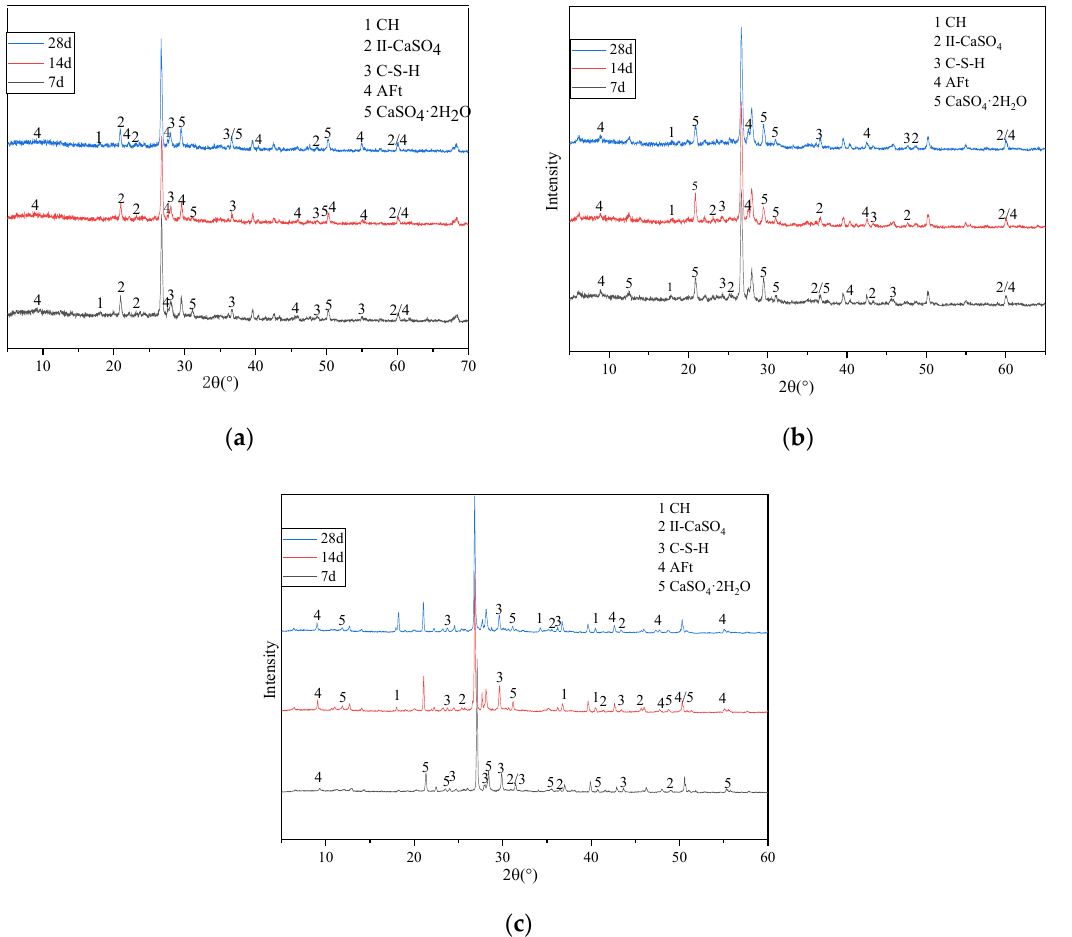
Figure 14. XRD patterns of samples with 30% cementitious material content after curing for 7, 14 and 28 days. ( a ) 30% cement. ( b ) 30% CFB-BA. ( c ) C/CFB = 2.